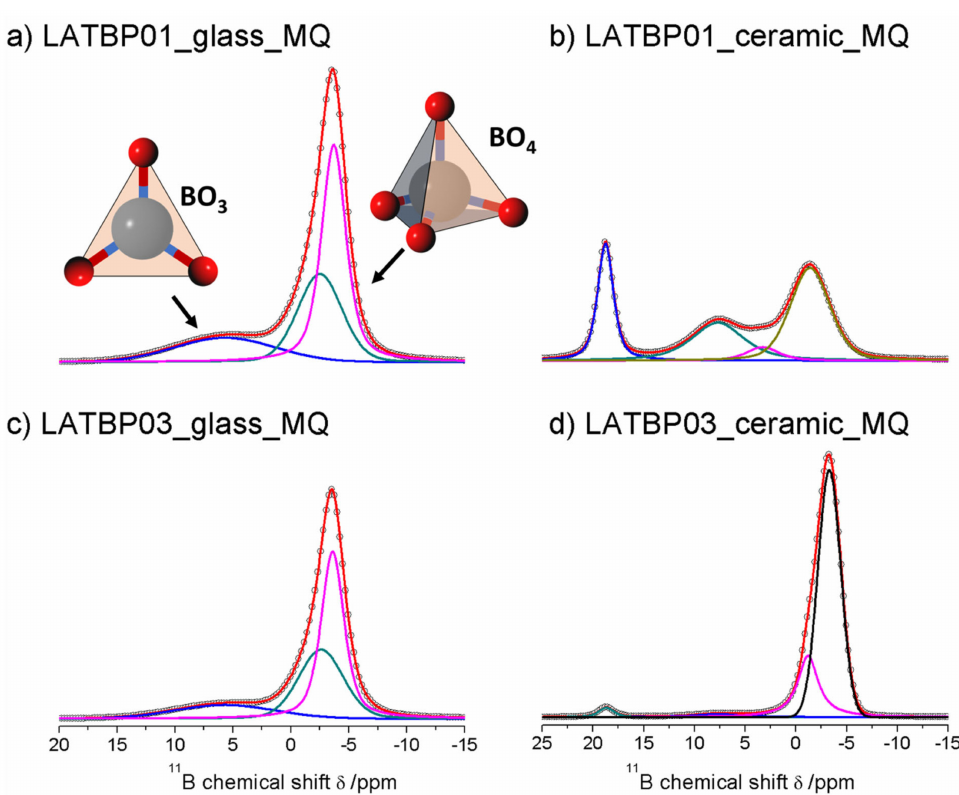
Figure 9. 1D 11 B MAS NMR spectra of the LAT(B)P_MQ series. ( a ) LATBP01_glass_MQ ( b ) LATBP01_ceramic_MQ ( c